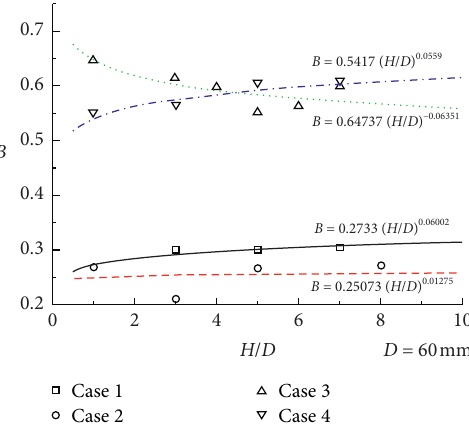
Figure 13: Relations between B and